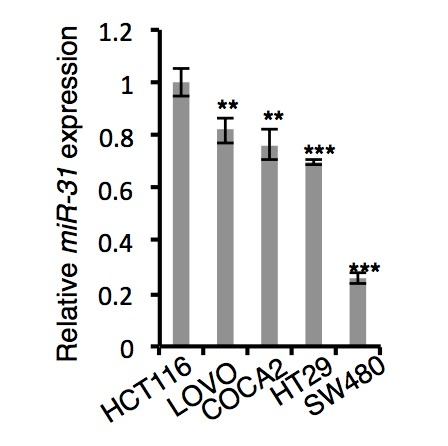
qRT-PCR analysis for miR-31 in HCT116, LOVO, COCA2, HT29 and SW480 colorectal cancer cells.